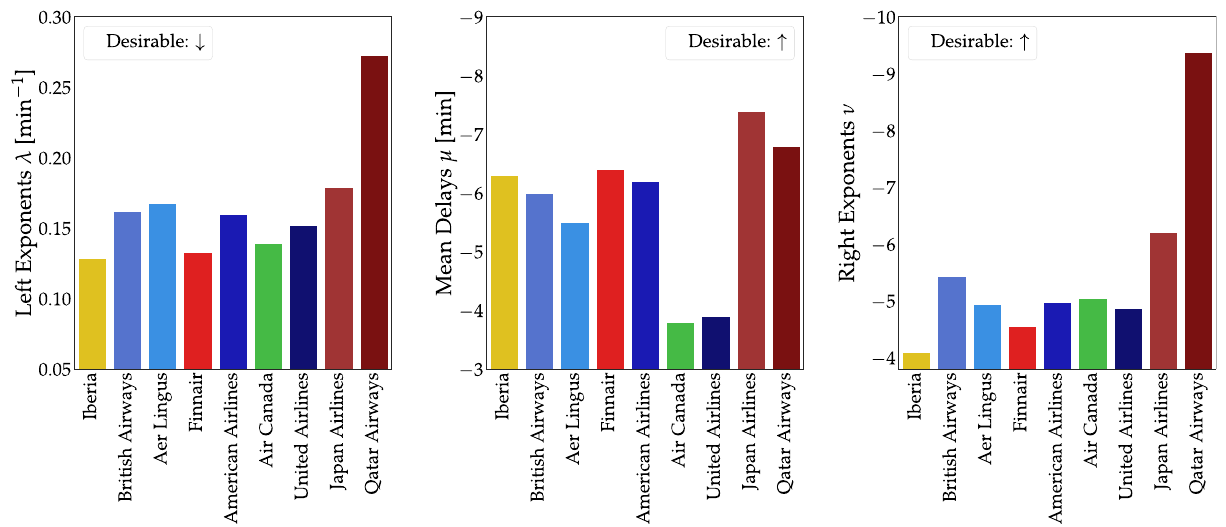
Figure 4. International airlines appear to differ substantially in their three delay indices. We plot the left-side (negative) delay exponential decay, right-side (positive) delay power-law decay and the mean delay. Arrows indicate whether a small or large value is